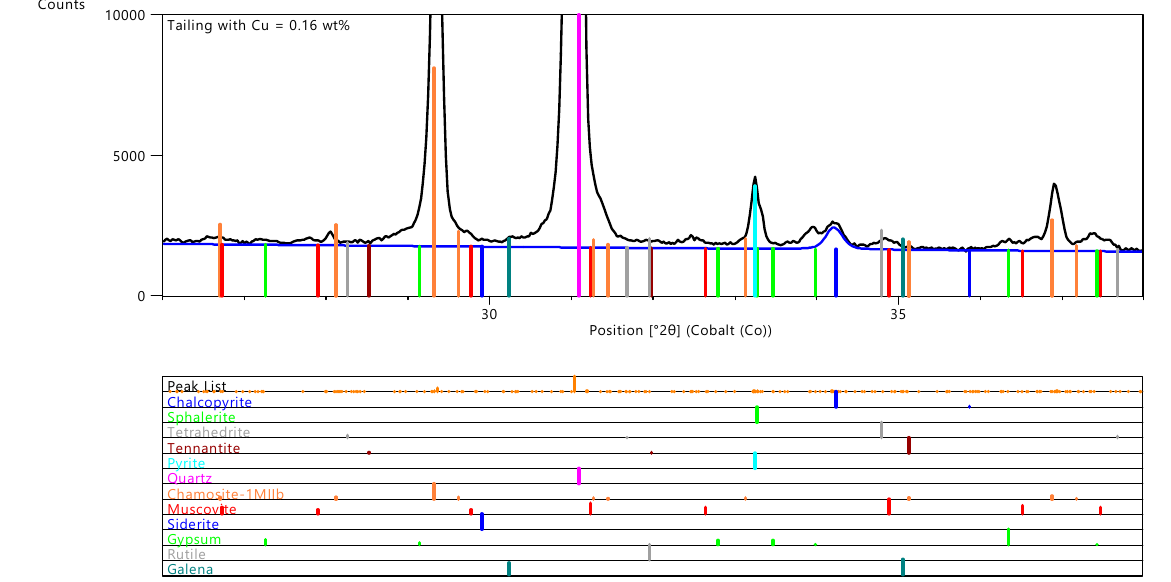
Figure 3. XRD pattern of a tailing sample with 0.16 wt% of copper in the range 26–38 ◦ 2 θ . Upper curve represents measured data, lower curve in blue represents Rietveld contribution of 0.45 wt% chalcopyrite. Vertical bars are peak positions of crystalline phases.